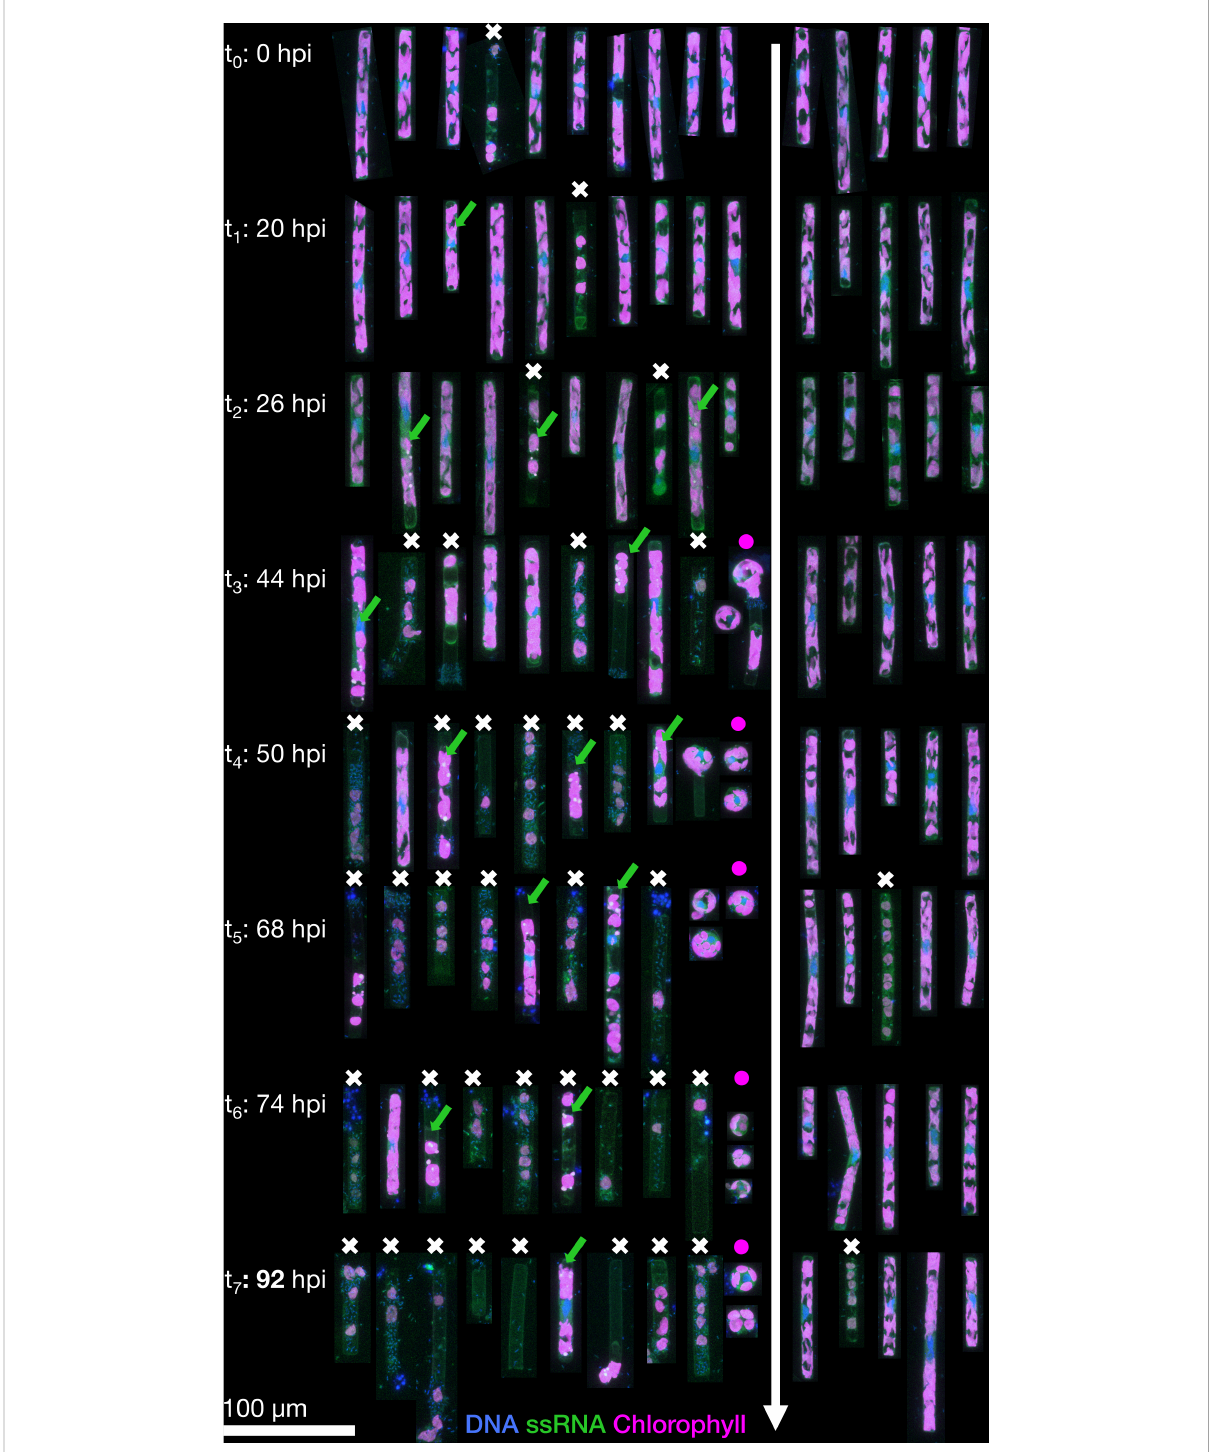
FIGURE 1 Representative Guinardia delicatula cells from samples infected with GdelRNAV-04 (left) and a non-infected control culture (right). Each cell is the depicted as the maximum projection of a corresponding 3D confocal dataset, with blue showing DNA and nuclei, green single-stranded RNA (including large viral accumulations, green arrows) and magenta auto fl uorescence from chlorophyll. Dead cells are highlighted by a white cross , and the increased formation of auxospores by purple dot